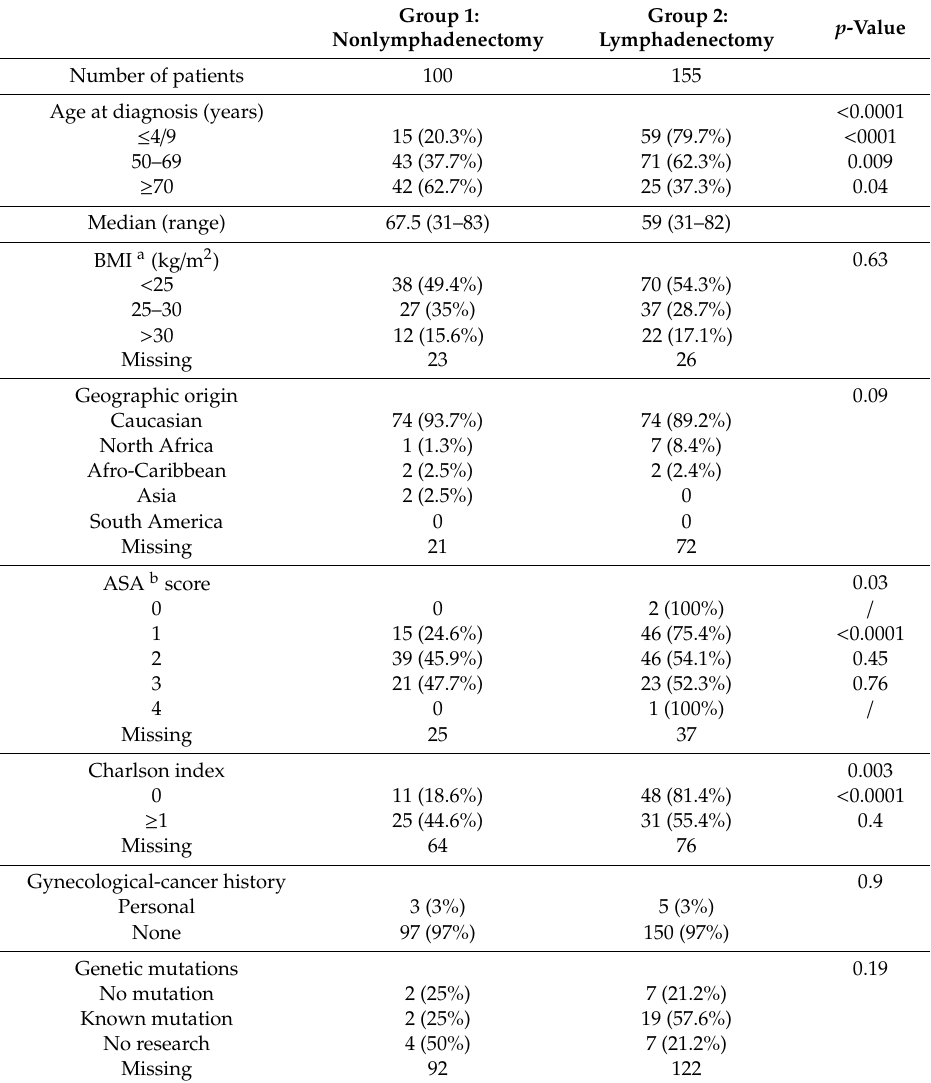
Table 1. Patient